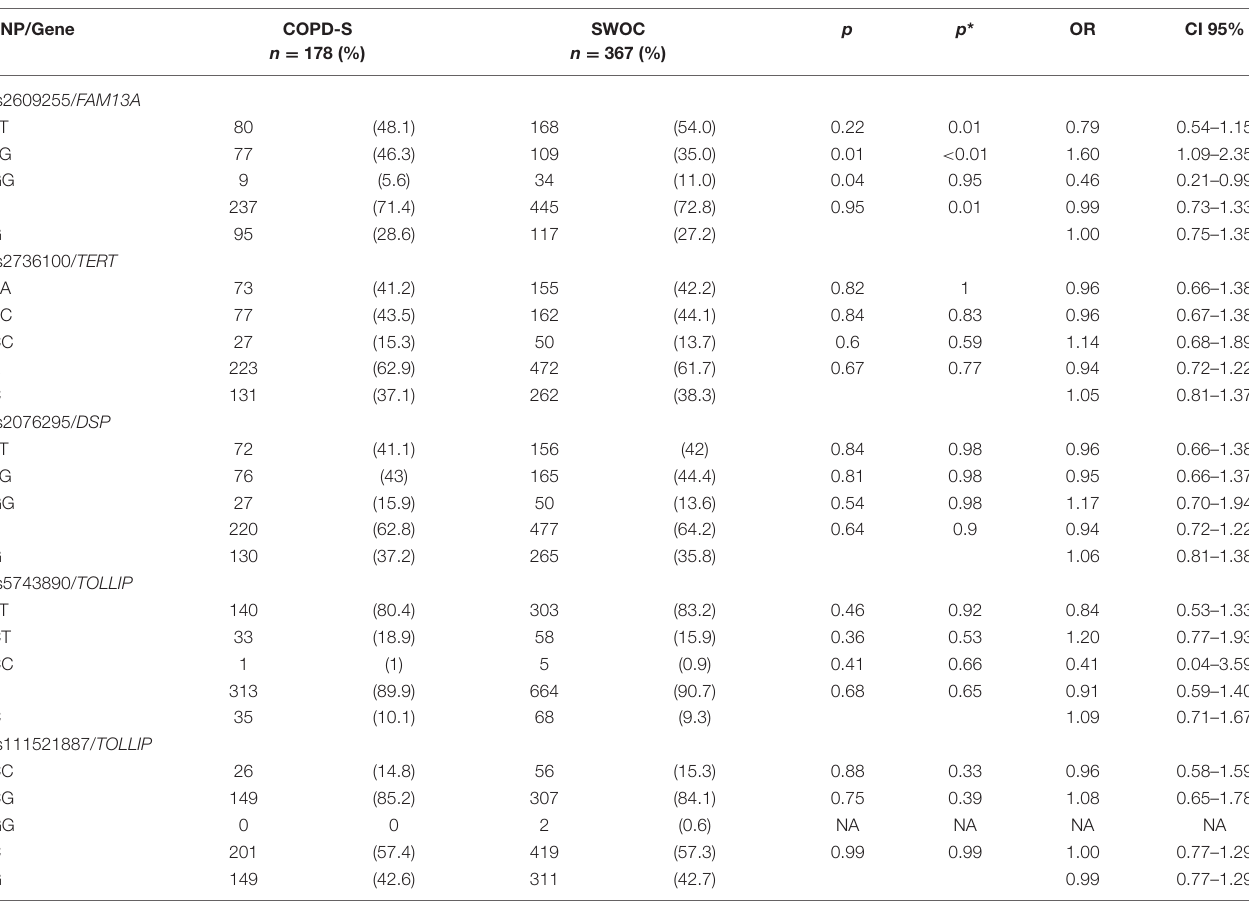
TABLE 2 | Allele and genotype frequencies of COPD-S vs. SWOC